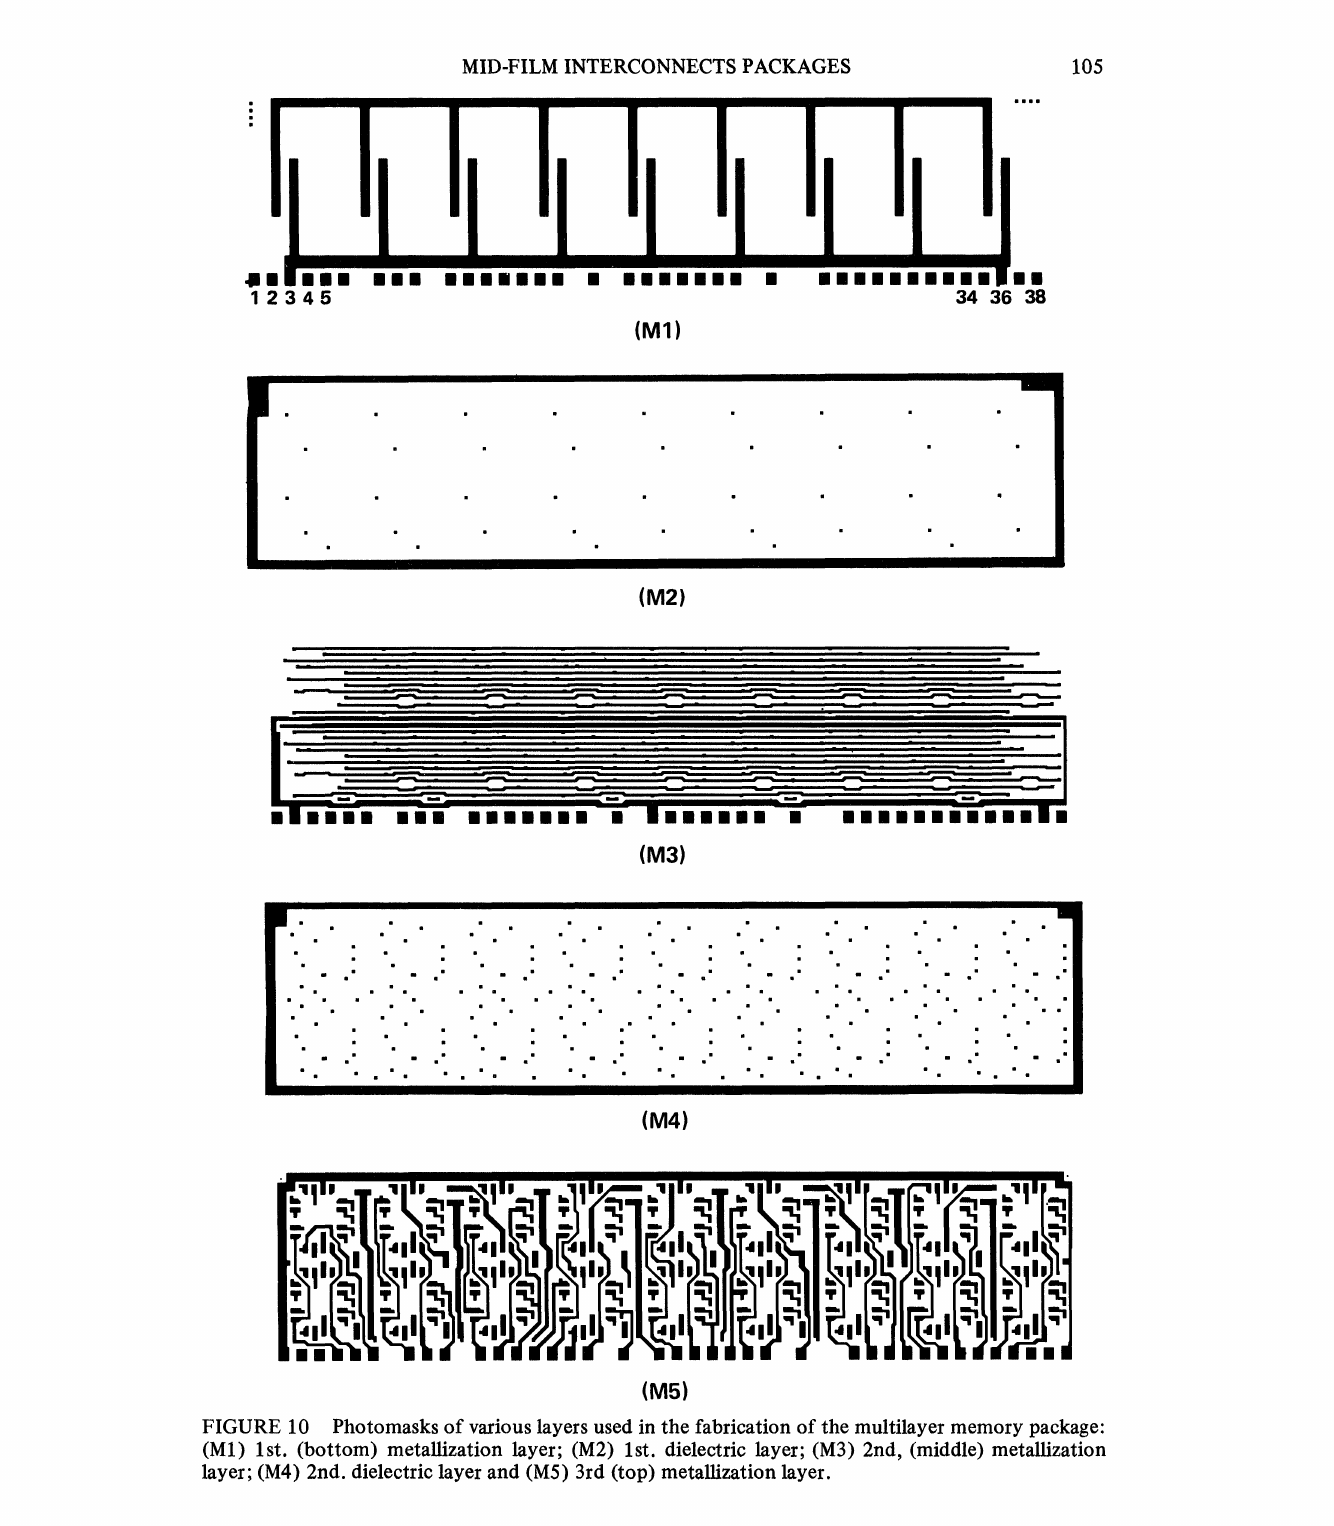
FIGURE 10 Photomasks of various layers used in the fabrication of the multilayer memory package: (M1) 1st. (bottom) metallization layer; (M2) 1st. dielectric layer; (M3) 2nd, (middle) metallization layer; (M4) 2nd. dielectric layer and (M5) 3rd (top) metallization